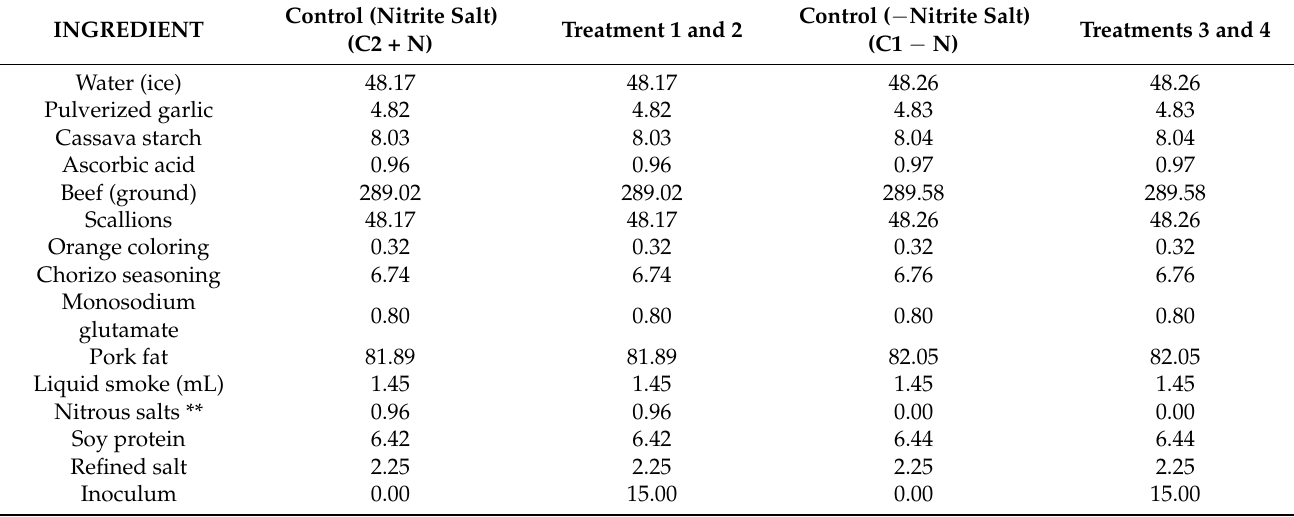
Table 2. Formulation for the manufacture of chorizo-type